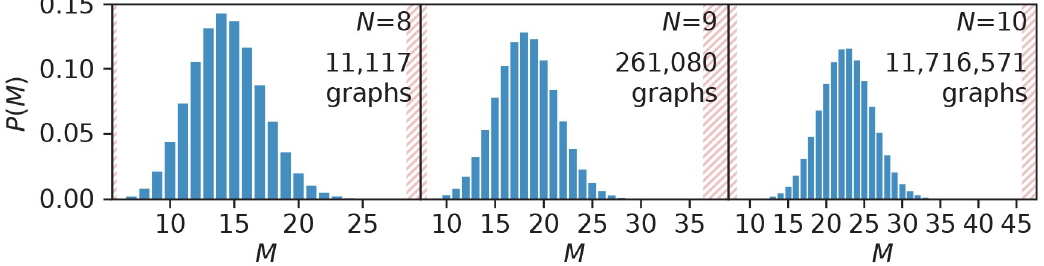
Fig 3. Small nonisomorphic graphs. The discrete probability distribution for the number of edges M across all nonisomorphic, connected, undirected graphs of 8 � N � 10. The shaded areas mark values outside of the bounds of M ( N − 1 � M � N ( N − 1)/2).